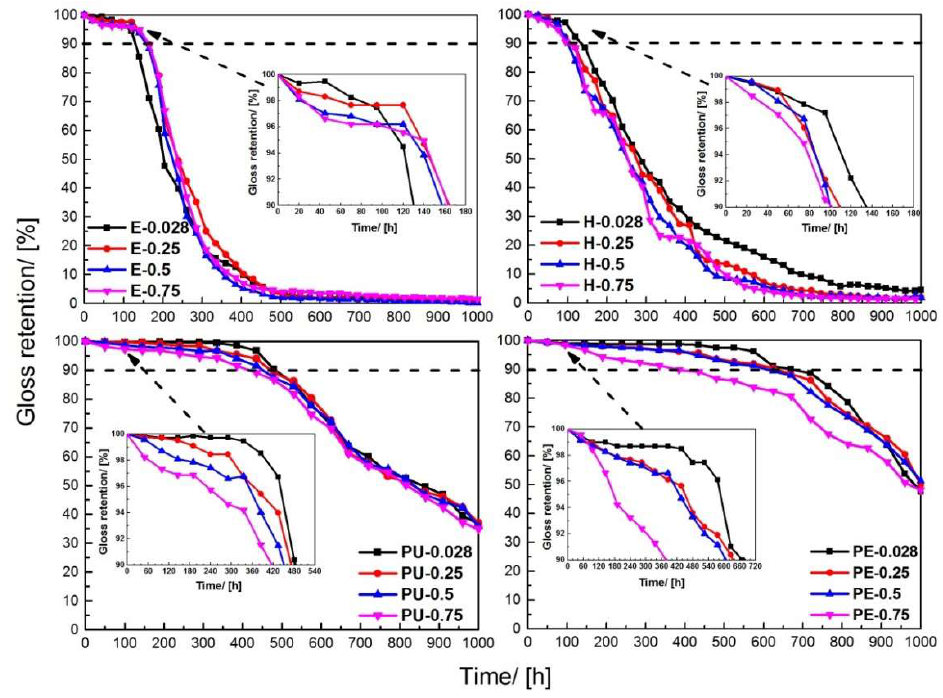
Figure 8. Specular gloss of panels against 1000 h of UV exposure (at 60°).